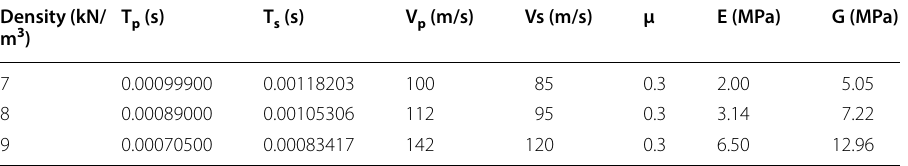
Table 5 The pulse velocities and elastic constants obtained from ultrasonic test Density (kN/ m 3